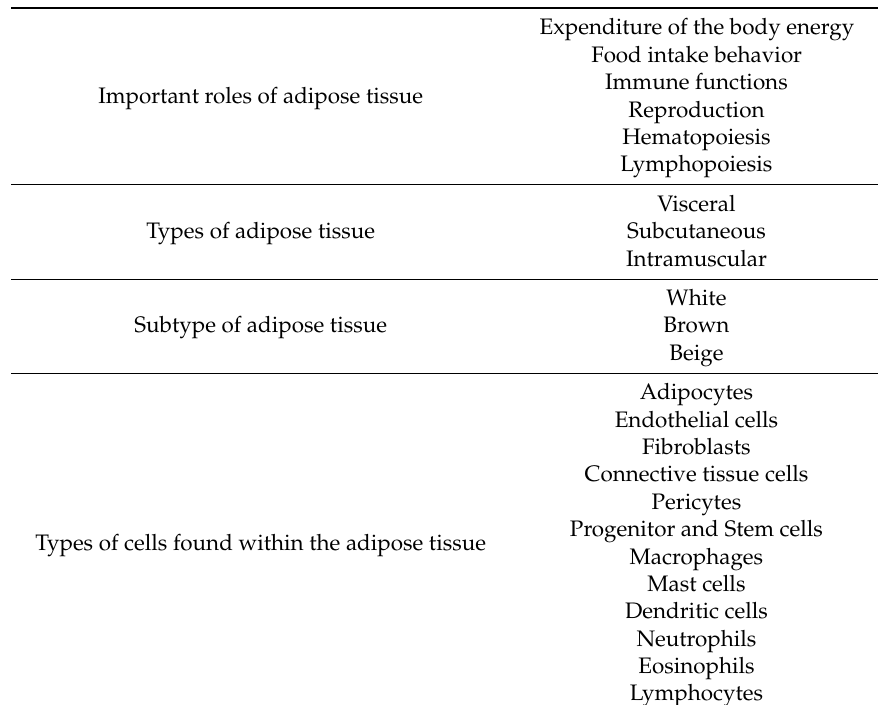
Table 2. General characteristics of the adipose